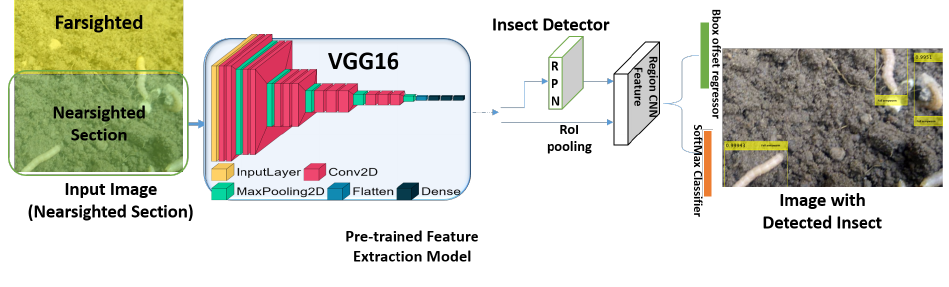
Figure 6. Network architecture of deep-learning insect pest detector with the best experimented pretrained